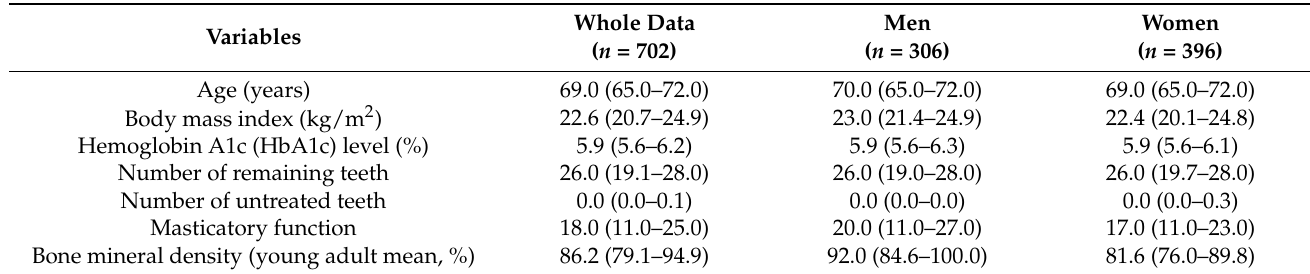
Table 1. Demographic data, overall and by sex.